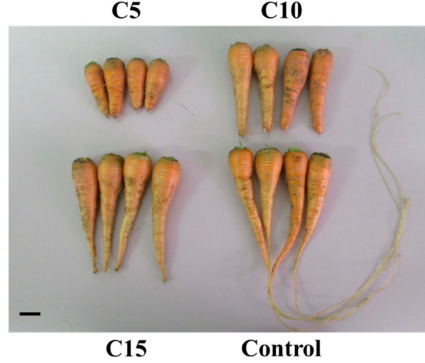
Figure 4. Taproot of carrots 28 days after partial taproot excision. Bar = 2.0